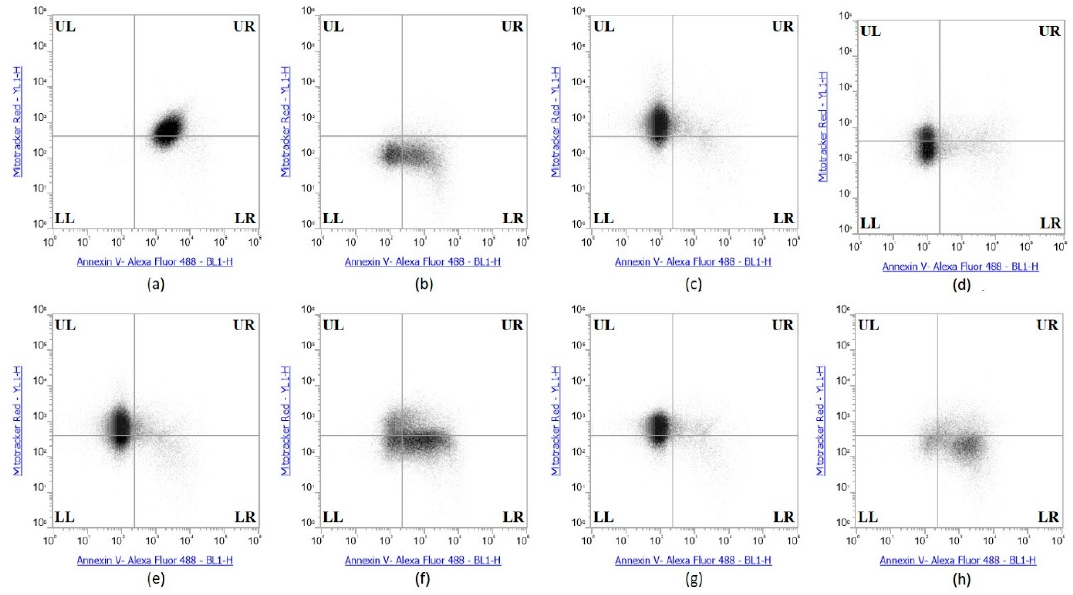
Figure 10. Se-Immunoconjugates induced greater apoptosis than native mAbs in MDA-MB-468 Cells. ( a ) Sutent (apoptosis control), ( b ) 0.1% Triton X-100 (necrosis control), ( c ) Control untreated ( d ) Selenite, ( e ) Bevacizumab, ( f ) Selenobevacizumab, ( g ) Trastuzumab, ( h ) Selenotrastuzumab Treatments. MDA-MB-468 cells were stained with Annexin V/MitoTracker Red and subjected to flow cytometric analysis. The four quadrants represent—living cells (Upper Left; UL: Annexin V, MitoTracker Red), early apoptotic (Upper Right; UR: Annexin V, MitoTracker Red), late apoptotic (Lower Right; LR: Annexin V, MitoTracker Red) or necrotic (Lower Left; LL: Annexin V, MitoTracker Red) stages.